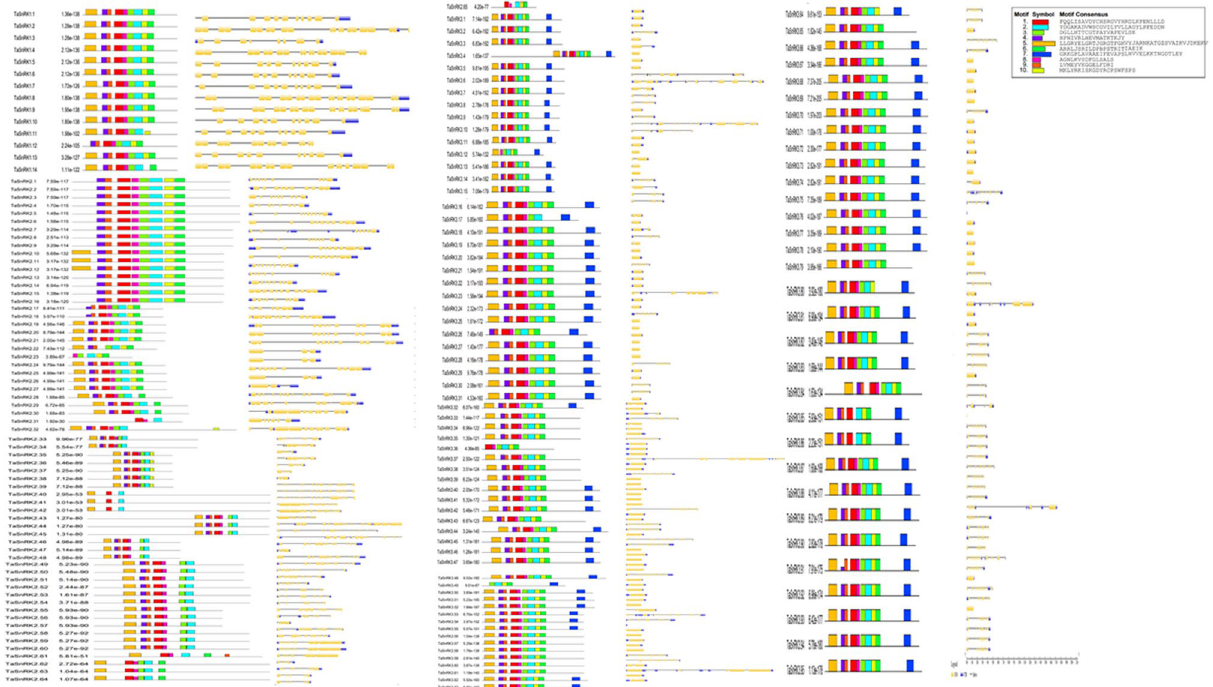
Figure 2. ( A ) Arrangement of ten conserved motifs in the TaSnRK genes following MEME analysis . Different colored boxes represent different motifs and their position in each sequence of TaSnRK genes. ( B ) Gene structure of wheat SnRK. Exons are indicated in yellow rectangles and grey line connecting two exons represent introns.